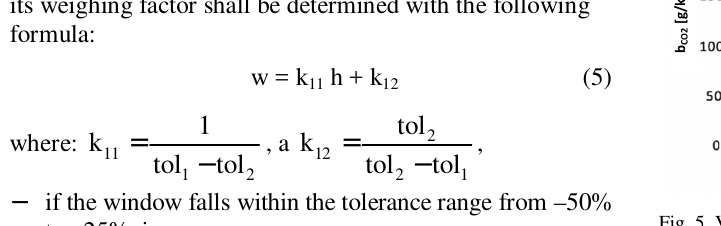
Fig. 5. Vehicle CO 2 characteristic curve with CO 2 emissions in respec- tive windows, during on-road tests [1–4]